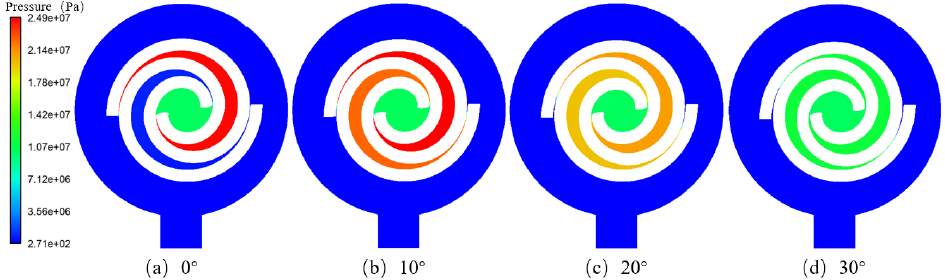
Figure 5. Pressure contour at different rotation angles.